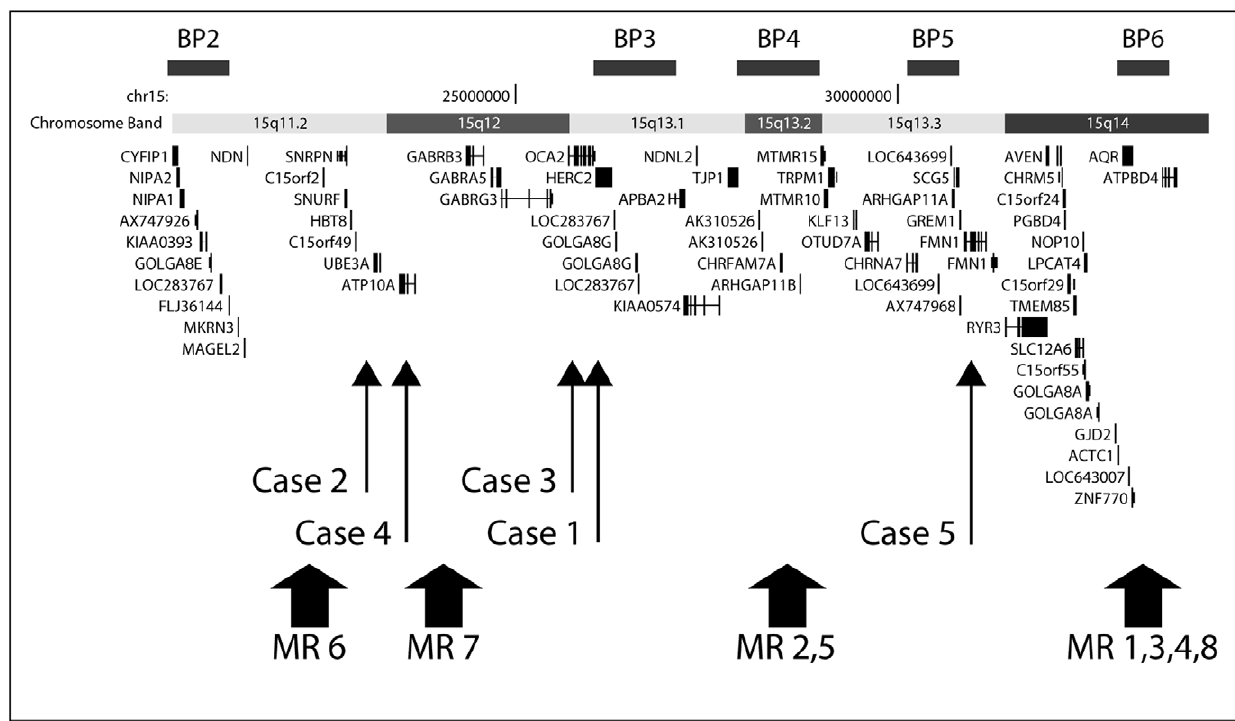
Figure 2. Physical map of the 15q11.2-q14 region. The six segmental duplication sites responsible for specific recurrent rearrangements in this region, known as BP1-6, are represented by black boxes. All genes in the region are shown. The position of the chromosome 15 breakpoints of the five translocation cases we have examined are represented by thin arrows. The positions of the eight translocation cases (MR1-8) described by Mignon-Ravix [10] are indicated by thick arrows.